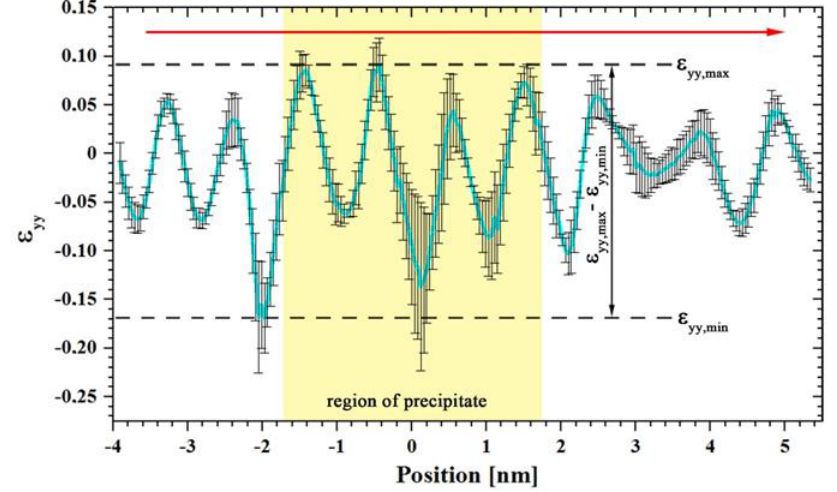
Figure 3. Line profile across the ε yy strain map shown in Figure Figure 3 . Line profile across the  yy strain map shown in Figure 2f.